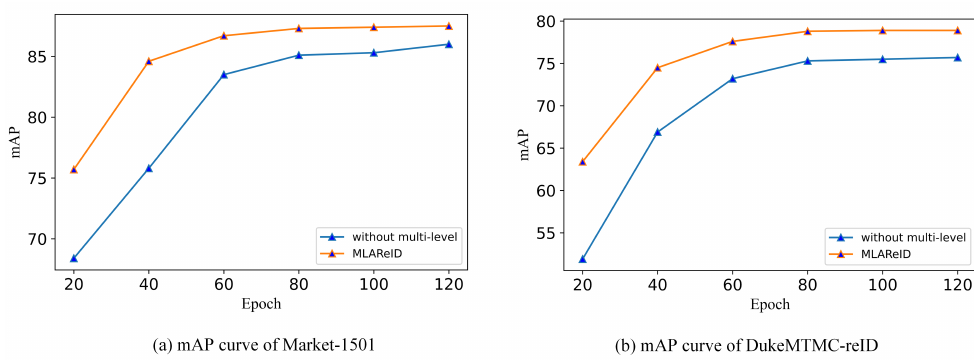
Figure 8. Whether to add multi-level fusion module on different datasets (mAP). Compared with without multi-level network, the proposed method achieves better mAP in training iteration.